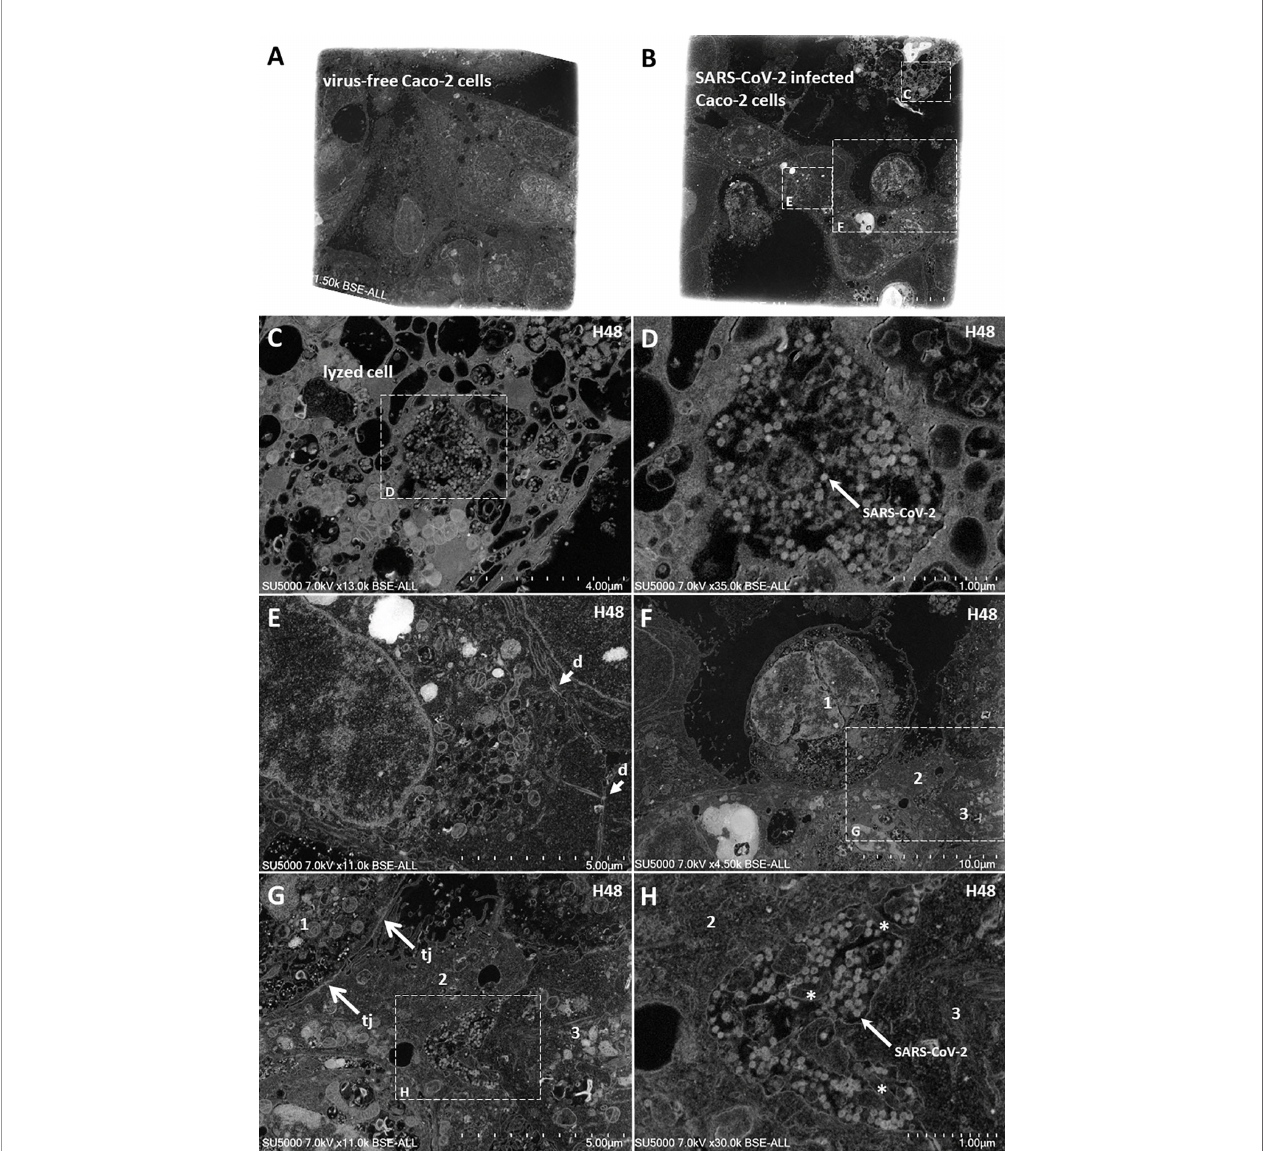
FIGURE 10 | Scanning electron microscopy of SARS-CoV-2 infected Caco-2 cells. (A, B) Low-magni fi cation images of virus-free Caco-2 cells monolayer at 0 hours- post-infection (H0; A ) and SARS-CoV-2 infected Caco-2 cells monolayer at 48 hours-post-infection (H48; B ). (C) Zoom-in boxed region from (B) with a lysed cell detached from the cell monolayer. (D) Zoom-in boxed region in lysed cell (C) with Sars-CoV-2 particles. (E) Intact stitched cells from the monolayer with presence of desmosomes (d; arrows) at cell-cell membranous contacts. (F) a cell (1) at the center, partially detached from surrounding cells. (G) partially detached cell (1) contacting cell (2) via tight junctions (tj; arrows). (H) Sars-CoV-2 particles located in the monolayer between intact cells (2) and (3), with presence of microvilli